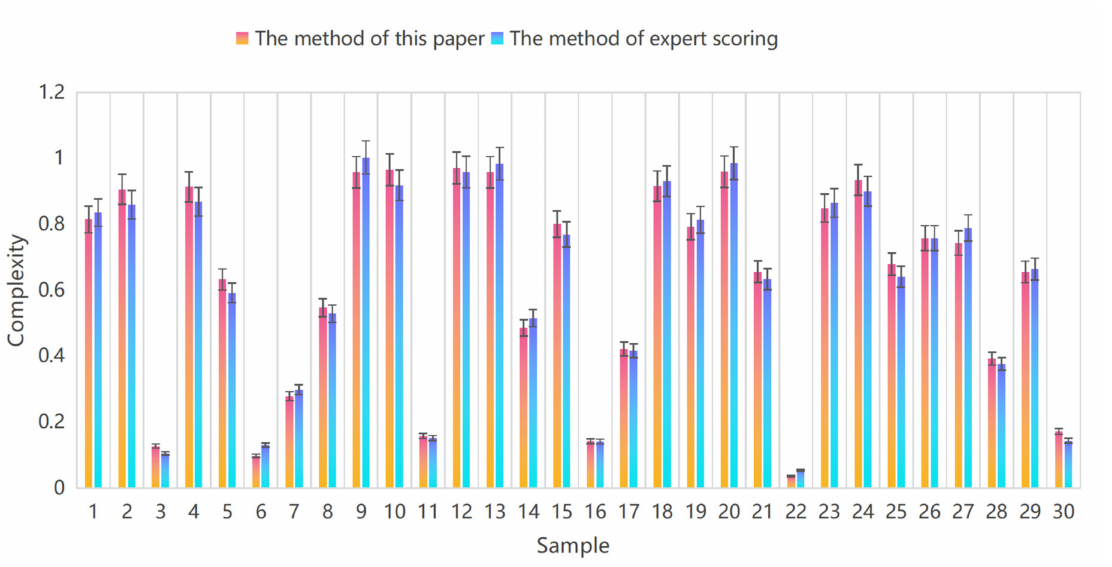
Figure 9. The analysis comparing the methods of this paper and the evaluation method of expert